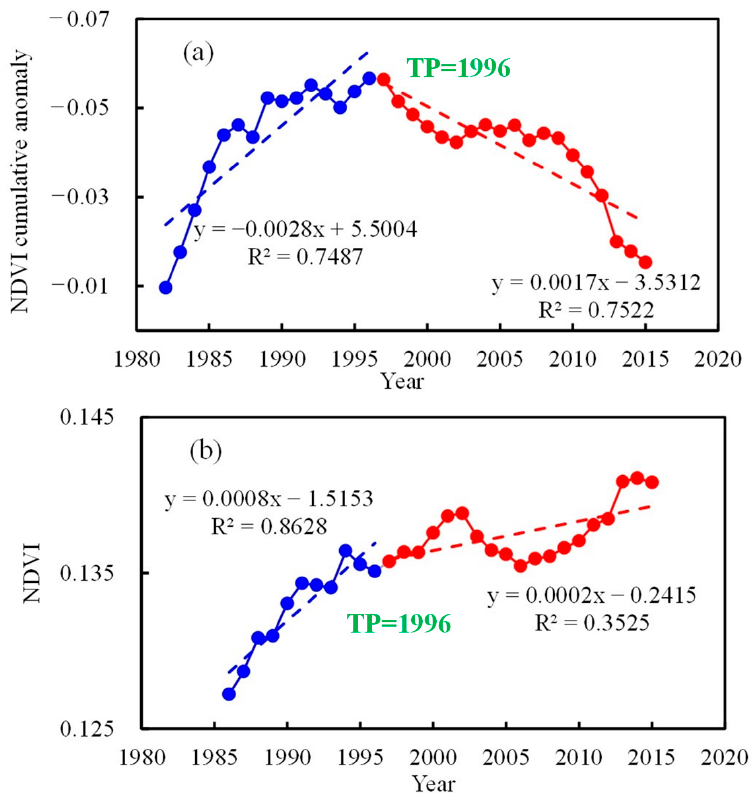
Figure 3. Cumulative anomaly ( a ) and 5-year moving average ( b ) of NDVI over the growing season. Blue and red lines represent the linear fit before and after the TP years.